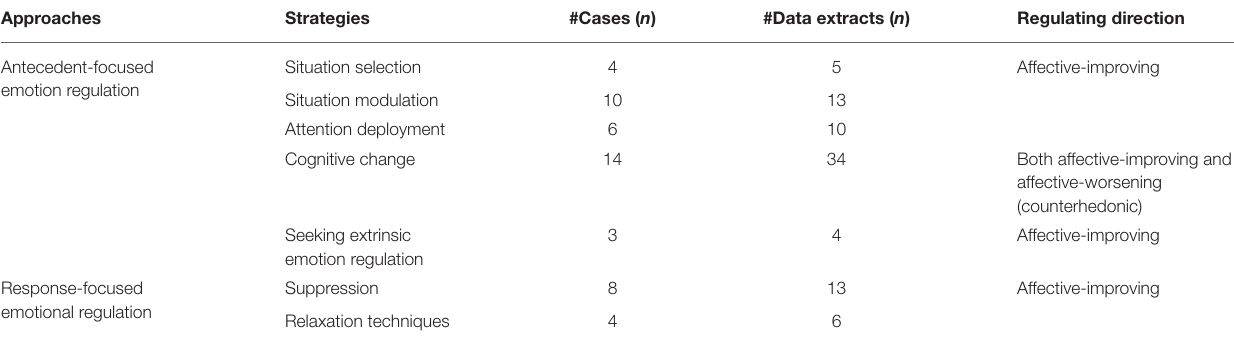
TABLE 4 | Summary of the participants’ intrinsic emotion regulation approaches and strategies.